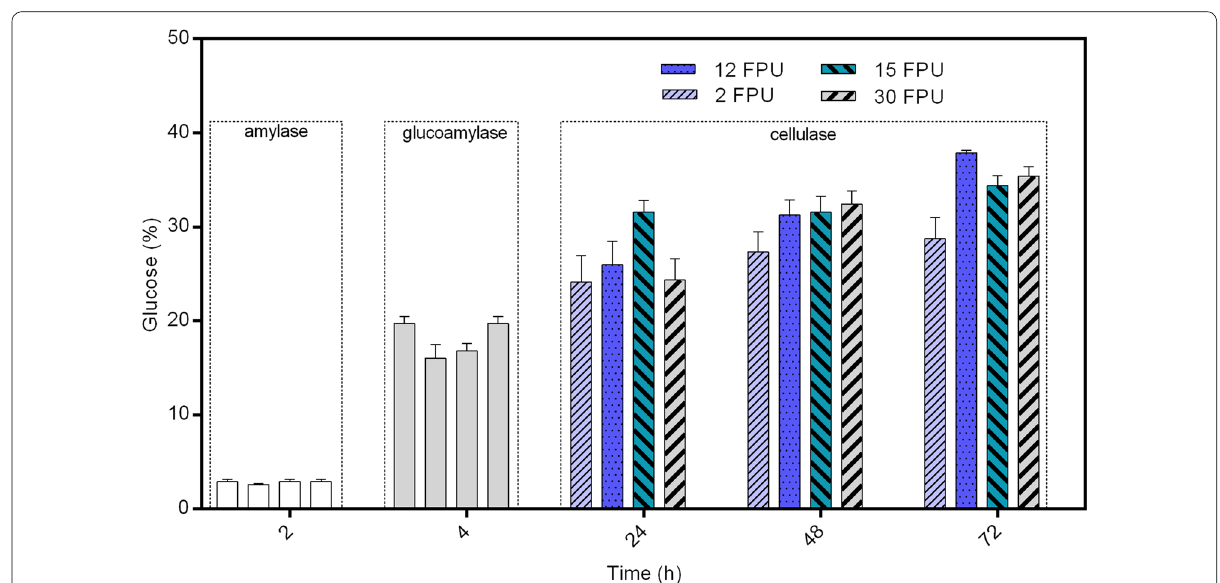
Fig. 1 Glucose concentration after enzymatic hydrolysis with α‑amylase (1.9 KNU), glucoamylase (1.8 AGU) and cellulase from 2 to 30 Filter Paper Unit (FPU) of 0.5% load biomass